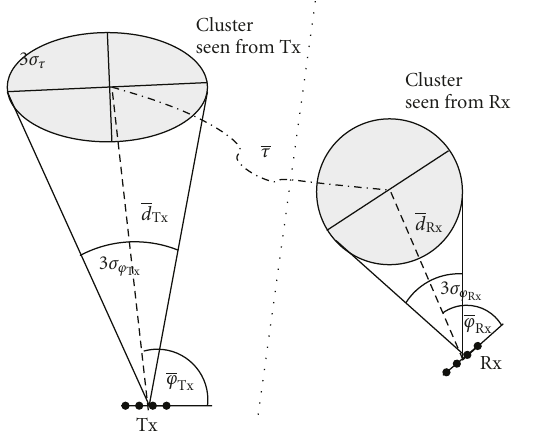
Figure 2: Geometrical interpretation of the RCM, demonstrated for a single